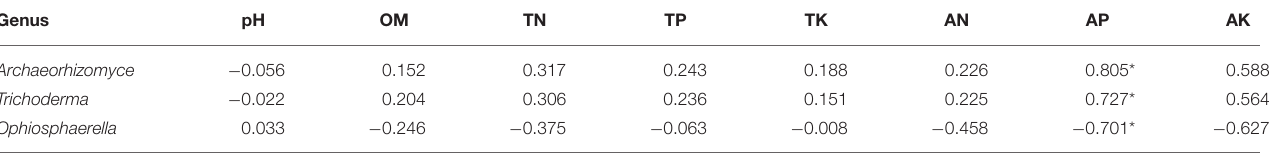
TABLE 2 | Pearson correlation coefficients between the key fungal genera and soil properties.